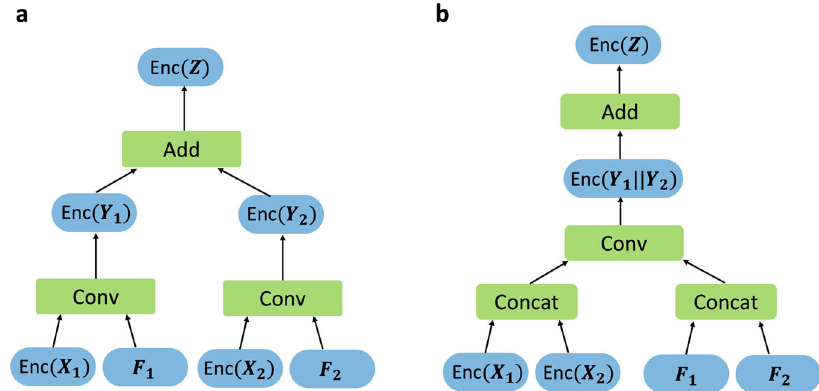
Fig. 2 | Multi-channel ordinary homomorphic convolution and fast homo- morphic convolution. We denote by Enc ( ⋅ ) an encryption function. Given an input tensor X with two channels X 1 and X 2 , Y i denotes an output by the single- input single-output convolution operation on the channel X i with the convolution kernel F i . Z indicates a generated output channel by the convolution on the input X , which can be computed as Z = Y 1 + Y 2 in the clear. a Ordinary homomorphic convolution. Conv indicates a single-input single-output homomorphic convolu- tion. Add indicates an ordinary homomorphic addition of two ciphertexts. b Fast homomorphic convolution. Concat indicates a concatenation over ciphertexts